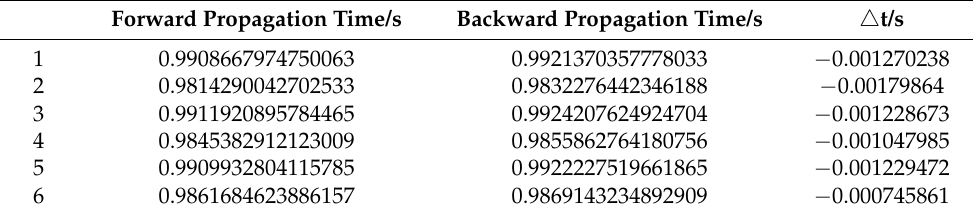
Table 1. Forward and backward propagation time.